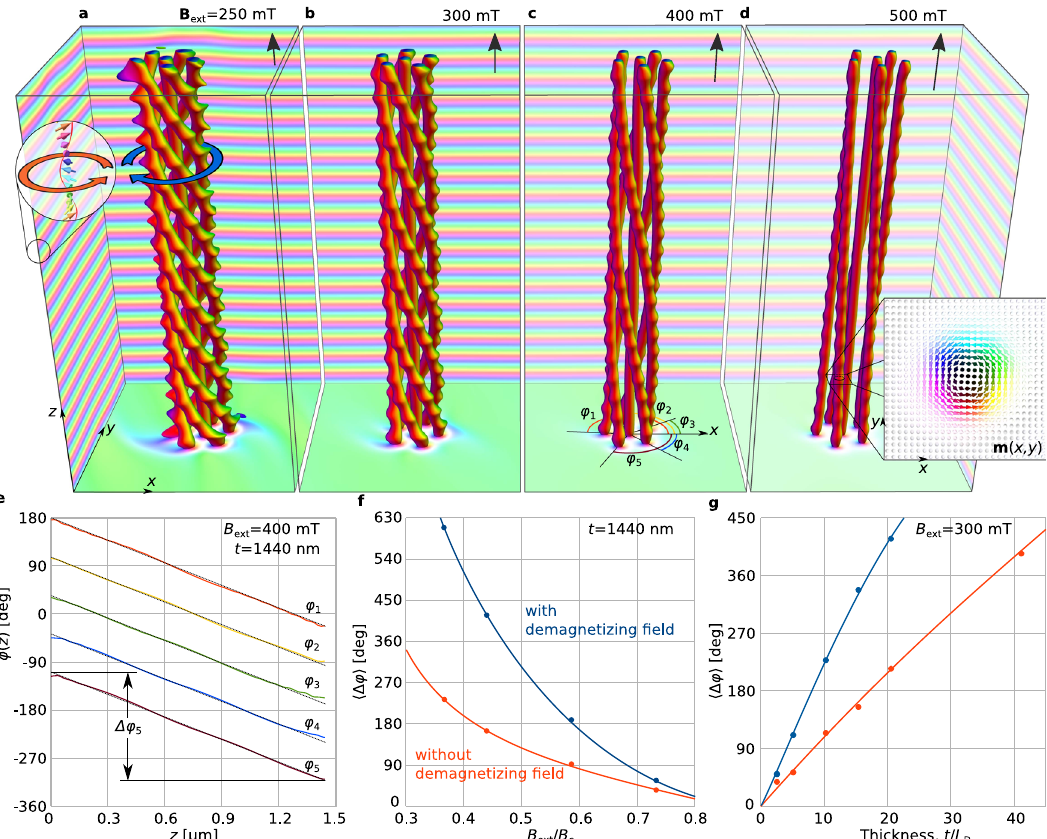
Fig. 1 Skyrmion braid in a chiral magnet. a – d Skyrmion braid comprising six skyrmion strings represented by isosurfaces of m z = 0. The color modulation at the edges of the box indicates the presence of the conical phase. (see inset in a ). The equilibrium state for each value of applied magnetic fi eld ( B ext jj ^ e z ) is found by using energy minimization (see “ Methods ” ), on the assumption of periodic boundary conditions in the xy plane, free surfaces in the third dimension, and a sample thickness of t = 1440 nm. The presence of bumps on the isosurfaces results from the magnetization modulations in the surrounding conical phase. These bumps become less pronounced with increasing B ext , as the cone phase approaches a fi eld-polarized state. e Dependence of twist angle on distance to the lower surface for the fi ve skyrmions that wind around a central sixth skyrmion. The angles φ i ( z ) are measured from the x axis, as indicated in c . The dotted lines are linear fi ts for each φ i ( z ) dependence. f Dependence of the average twist angle h Δ φ i ¼ 1 applied magnetic fi eld. g Dependence of the average twist angle 〈 Δ φ 〉 on sample thickness t . The solid circles in f , g are obtained from numerical calculations, while the lines are used to guide the